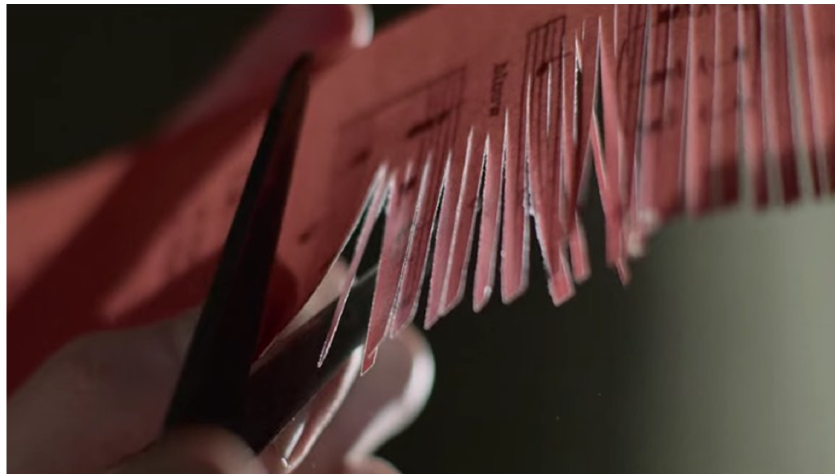
Figure 1. The Power of the Dog . Netflix.